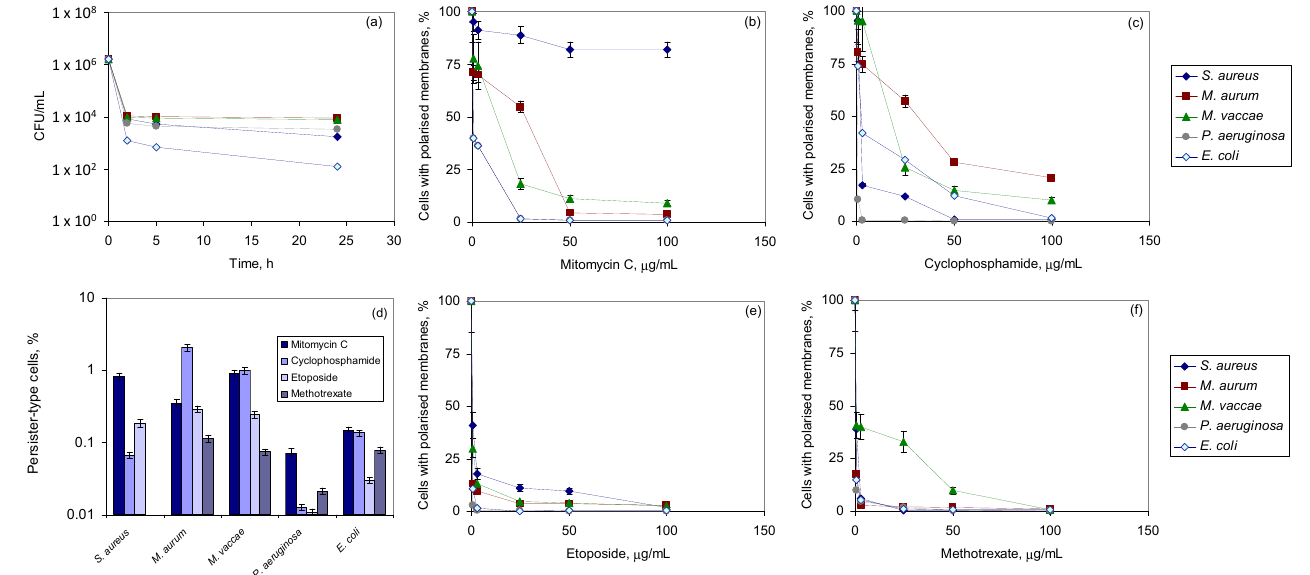
Figure 1. Persistence induced with antineoplastic agents. ( a ) Time-dependent killing curves during exposure to 100 μ g/mL of mitomycin. Percentage of cells with polarized membranes following exposure to increasing concentrations of mitomycin ( b ), cyclophosphamide ( c ), etoposide ( e ), and methotrexate ( f ). ( d ) Percentage of persister-type cells observed after 24 h of exposure to 100 μ g/mL of each antineoplastic for each tested strain. Results are the average of three independent bioconversions. Data are presented as mean ± standard deviation; assays were performed in triplicate.